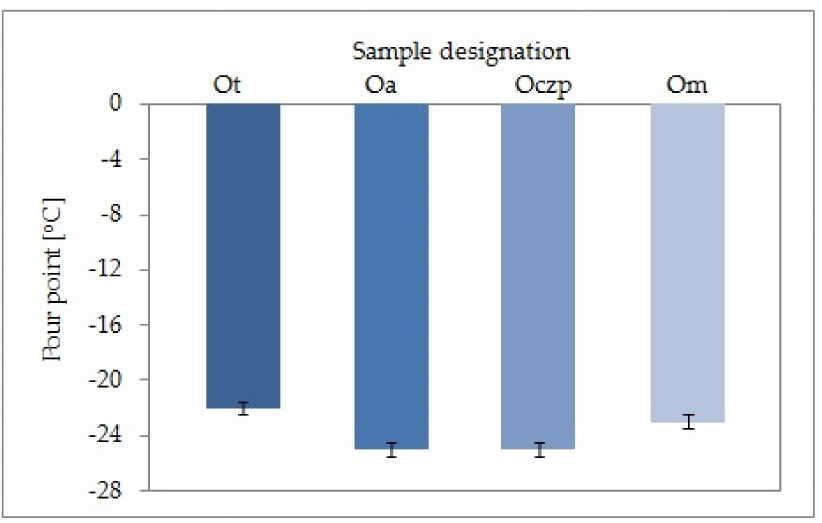
Figure 6. The pour points of the tested oils. Ot = strawberry seed oil, Oa = chokeberry seed oil, Oczp = black currant seed oil and Om = raspberry seed oil.